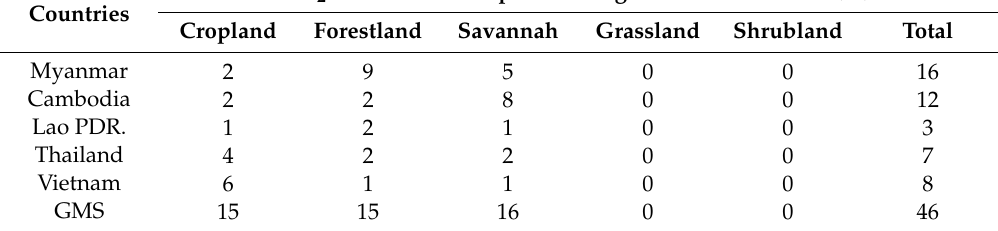
Table A6. The actual amount of SO 2 from biomass open burning classified by vegetation types in the GMS in 2015. Countries